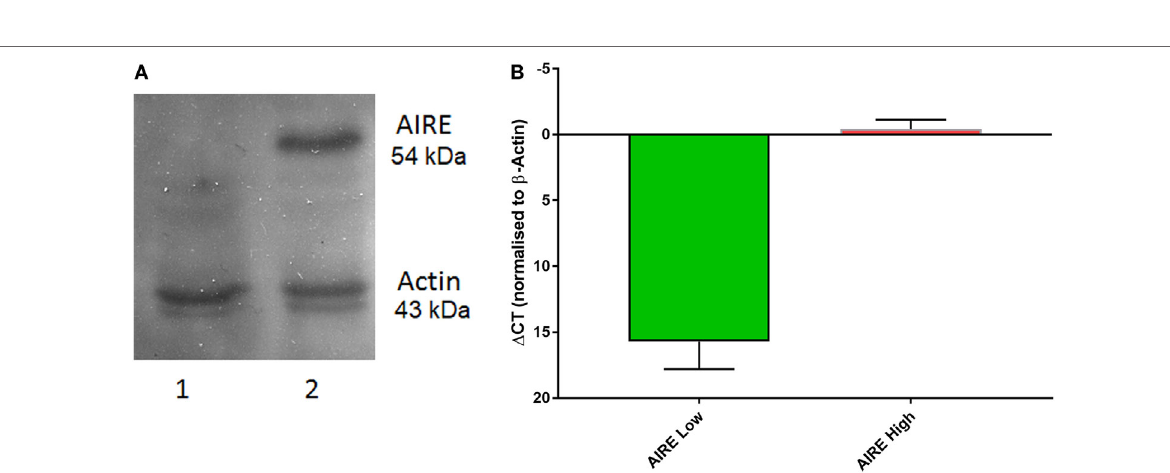
FigUre 1 | Basic principle of the Flp-In system of site-specific recombination to integrate a single copy of the pcDNA5/FRT expression vector containing autoimmune regulator cDNA into the genome of the target host cell line (TEC